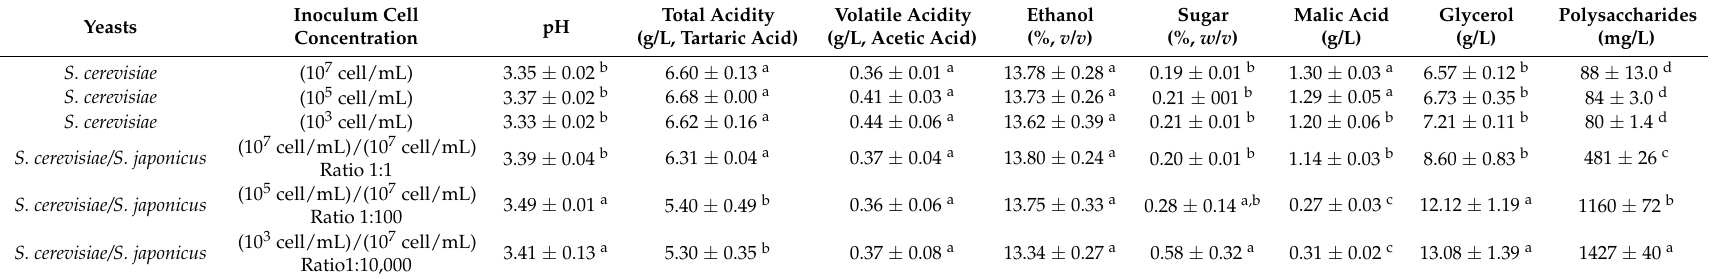
Table 1. Analytical profile of wines obtained with S. cerevisiae EC1118 in pure cultures and in mixed cultures with S. japonicus #13.